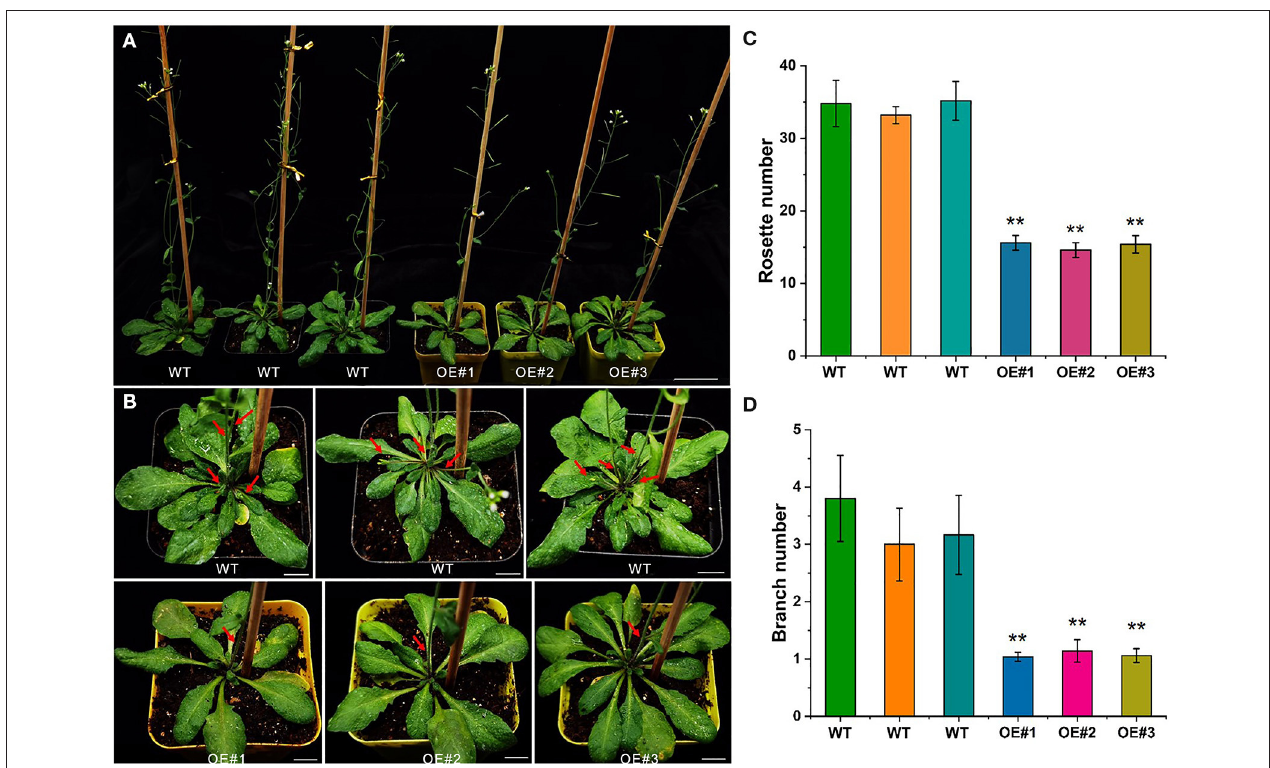
FIGURE 12 | Phenotypic assay of the DlTCP12-C overexpression transgenic Arabidopsis . (A) Branching phenotypes of 35-day-old wild-type and DlTCP12-C overexpressing transgenic Arabidopsis lines. Scale bar = 4cm. (B) Close-up views of the rosettes of the plants in (A) . Red arrow indicates branch. Scale bar = 1cm. (C) Number of rosettes. Error bars were obtained from five replicates. (D) Number of branches. Error bars were obtained from five replicates. Significant differences compared with the WT were analyzed by Student’s t -test: ** p <